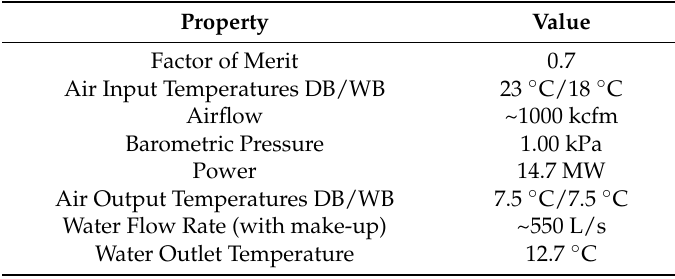
Table 5. Cooling characteristics of the surface plant.